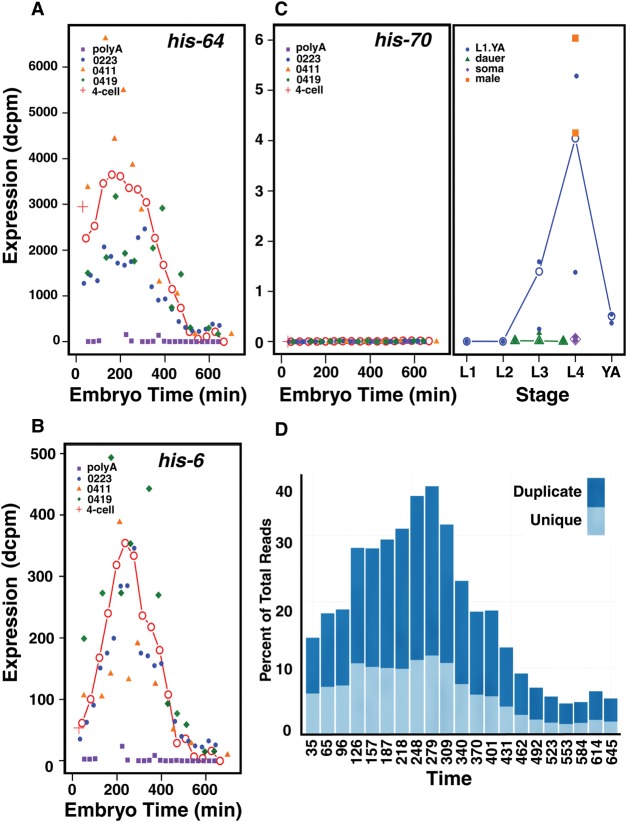
Histone expression across development. (A) The expression in dcpm of the replicative histone, his-64, an example of a pattern with a substantial maternal component. The expression is shown across embryogenesis (labeled in embryo time) for the unified series (red line, open circles), the three rRNA subtracted series (blue, orange, and green), and the poly(A)-selected series (purple) along with the single four-cell sample (red cross). Its pattern is typical of the genes located in the clusters on Chromosome IV. (B) The expression in dcpm of the replicative histone, his-6, an example of a largely zygotically expressed histone. The pattern is shown across the same time points, colored as in A. Its expression pattern is typical of the histone clusters on Chromosomes I and V. (C) The expression in dcpm of his-70, a C-terminally truncated H3.3 variant (Ooi et al. 2006), is shown across embryogenesis (left) and into larval and adult time points (right). The gene lacks an intron but apparently has a poly(A) tail. The embryogenesis time points are colored as in A, the late time points are for L1 through young adult (blue), the dauer stages (green), soma (purple), and male (orange). Both the individual samples (closed symbols) and weighted averages (open symbols) are shown. Post-embryonic time points are shown in approximate chronological order. (D) The percentage of total aligned sequence reads specific to histone genes during embryonic development (time in minutes) for the 0223 rRNA subtracted series (0223) is shown. Uniquely aligned reads are shown in light blue, whereas sequence reads aligning equally to multiple histone gene family members are shown in dark blue.